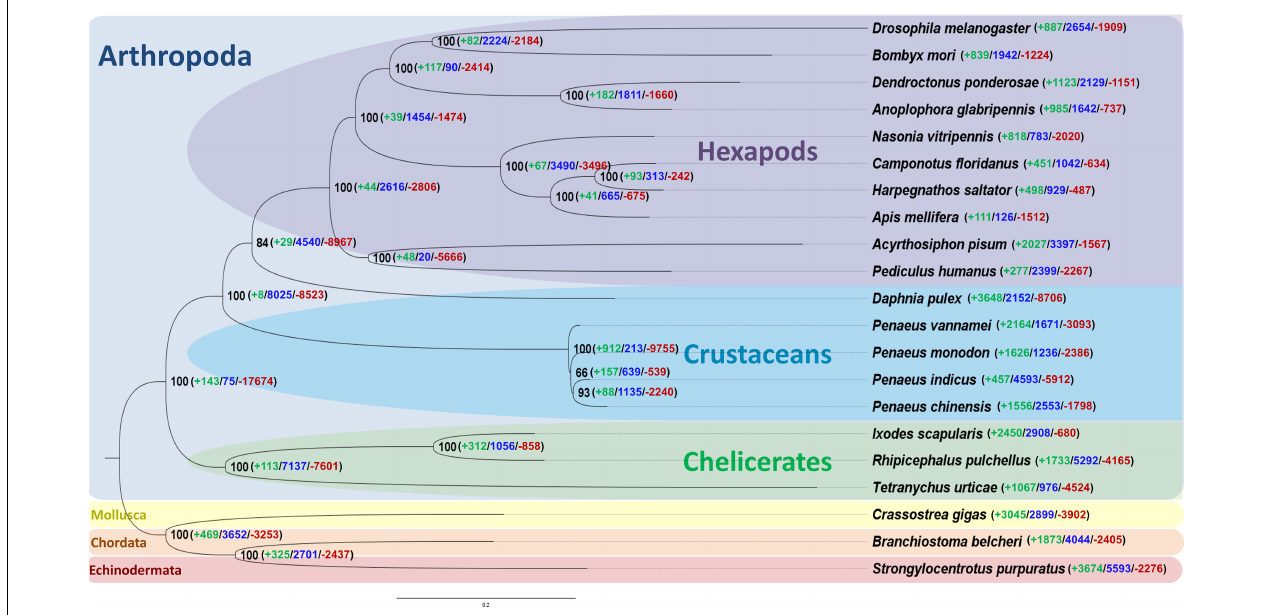
FIGURE 4 | Phylogenetic placement of Penaeus indicus among Arthropods. Numbers at the nodes are bootstrap values and those given in the parenthesis indicate number of gene families that were expanding (green), rapidly evolving (blue), and contracting (red).